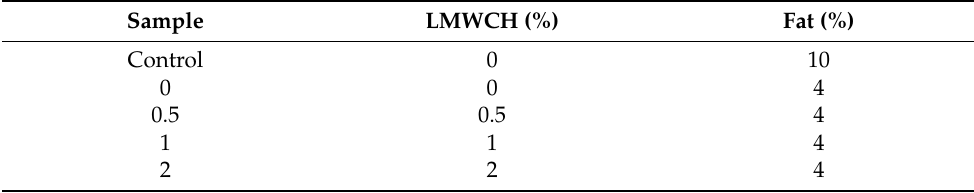
Table 1. Formulations of five different beef